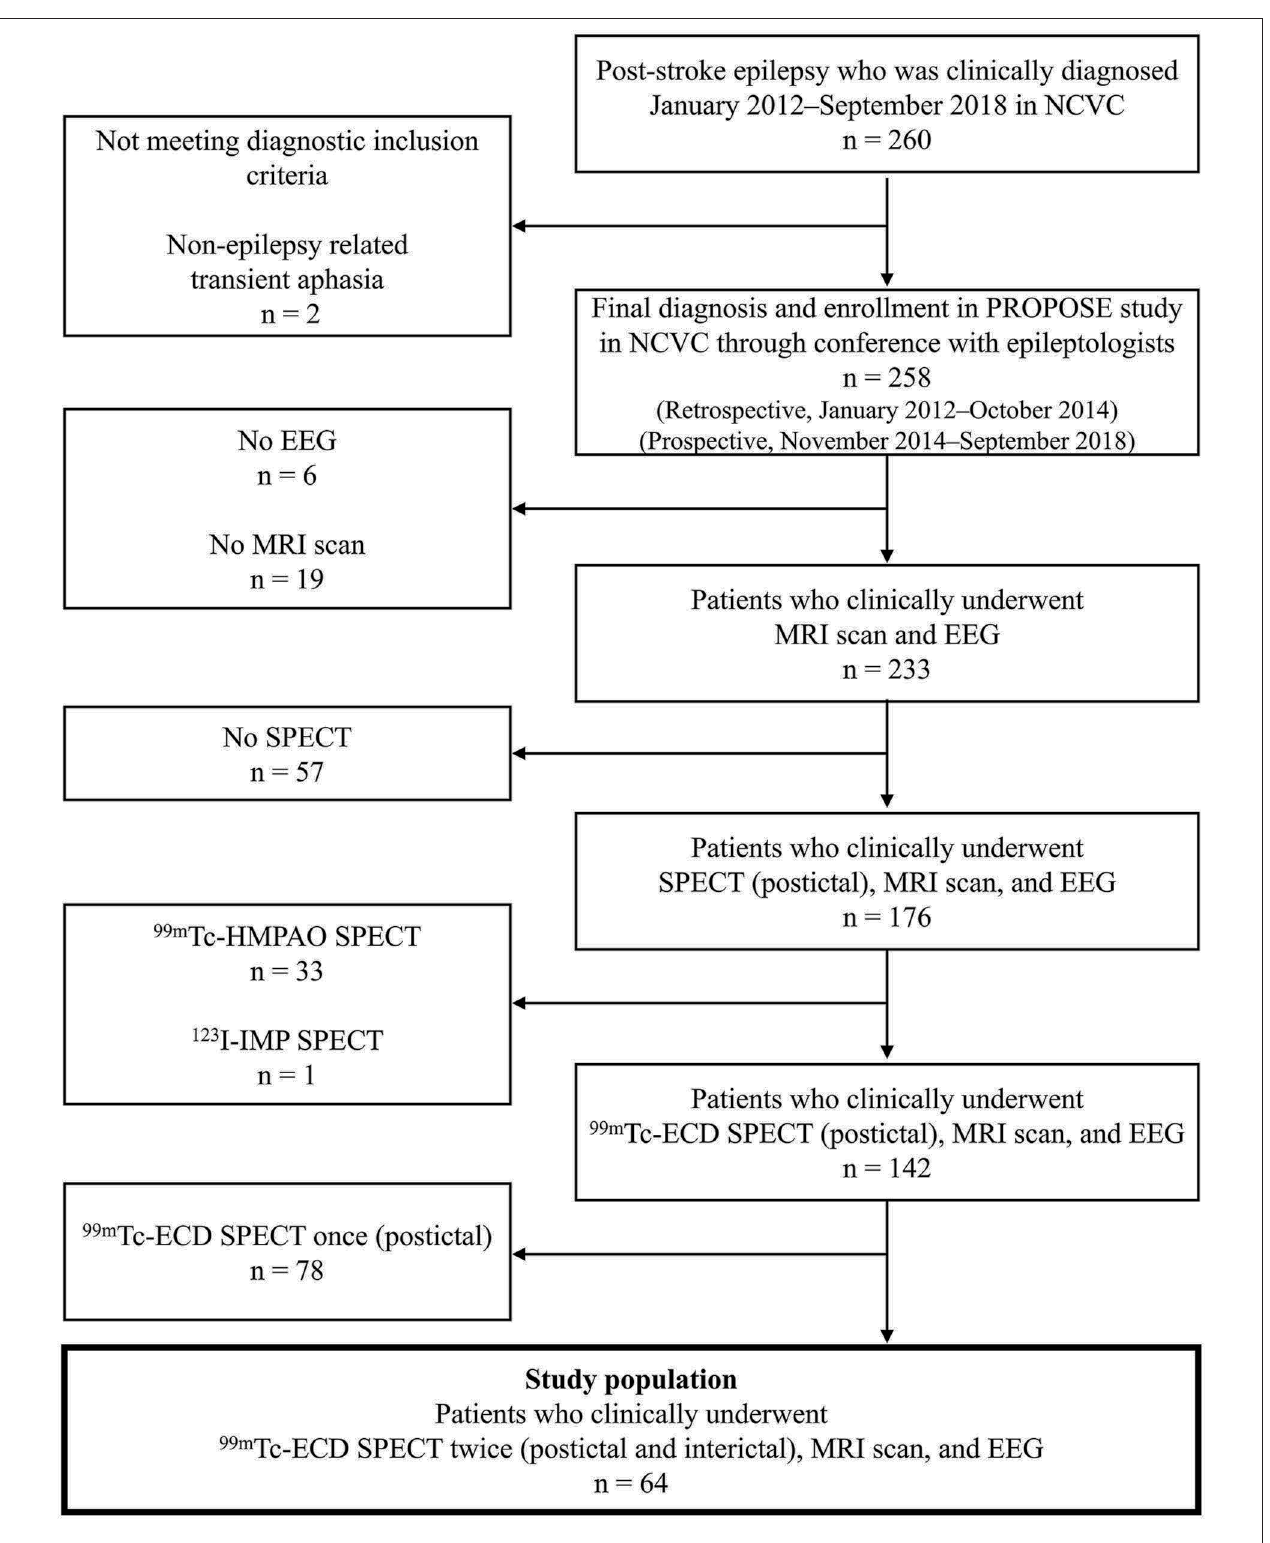
FIGURE 1 | Patient enrollment. ECD, ethyl cysteinate dimer; EEG, electroencephalography; HMPAO, hexamethyl propylene amine oxime; IMP, iodoamphetamine; NCVC, National Cerebral and Cardiovascular Center.